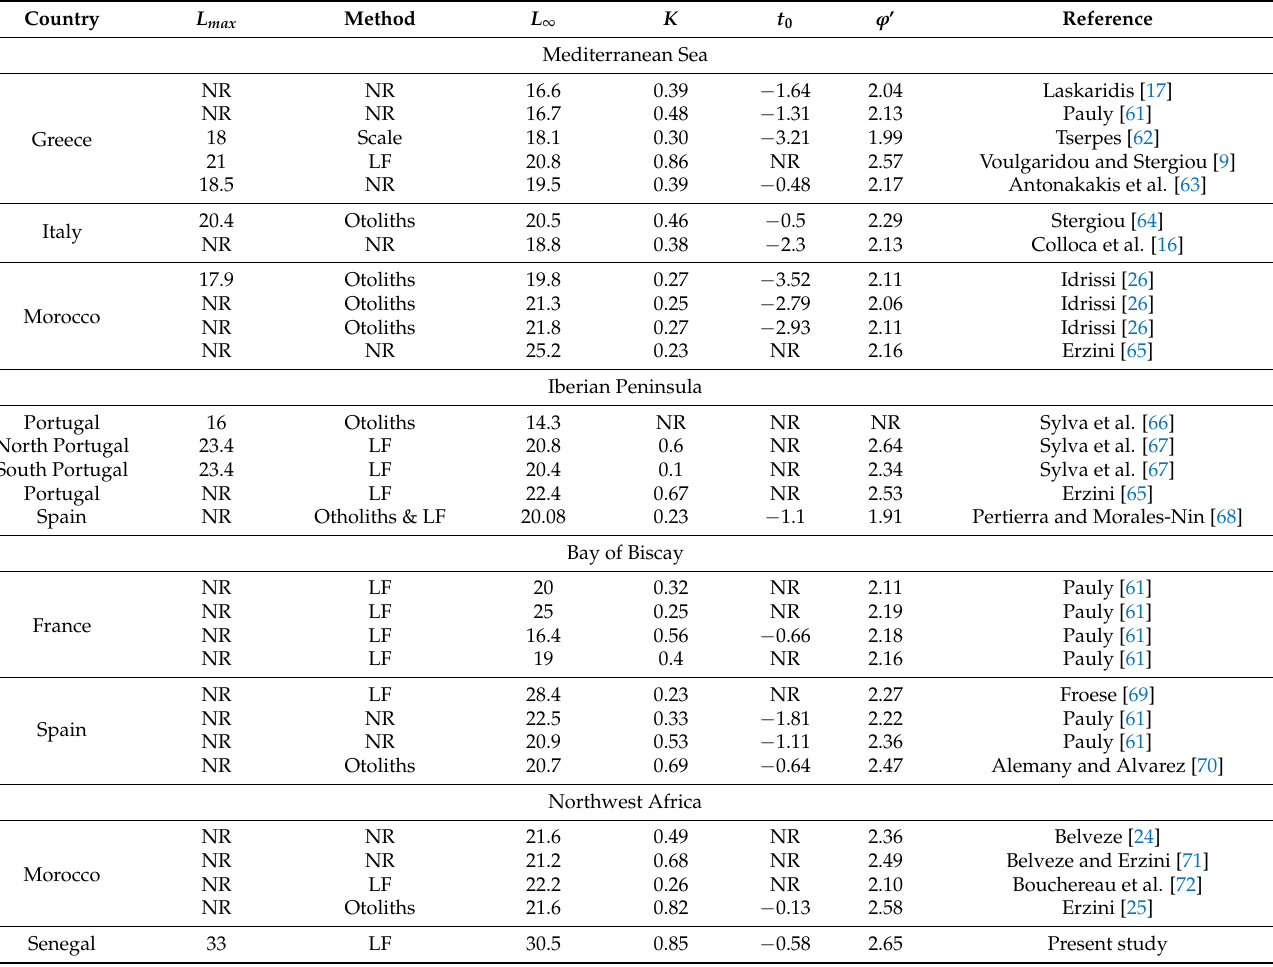
Table 2. Growth parameters of Sardina pilchardus (unsexed) estimated in Northern Senegal (present study) and in Northwest Africa, Iberian Peninsula, Bay of Biscay, and the Mediterranean Sea. The growth parameters were estimated according to three different methods, i.e., scale, otoliths, or length frequencies as in the present study (size expressed in cm and Total length). L max : maximum recorded length (cm); L ∞ : L t value when the growth rate is zero; K : coefficient of growth rate, t 0 : theoretical time “ t ” when the fish length is zero, ϕ (cid:48) : growth performance index. NR: not reported, LF: